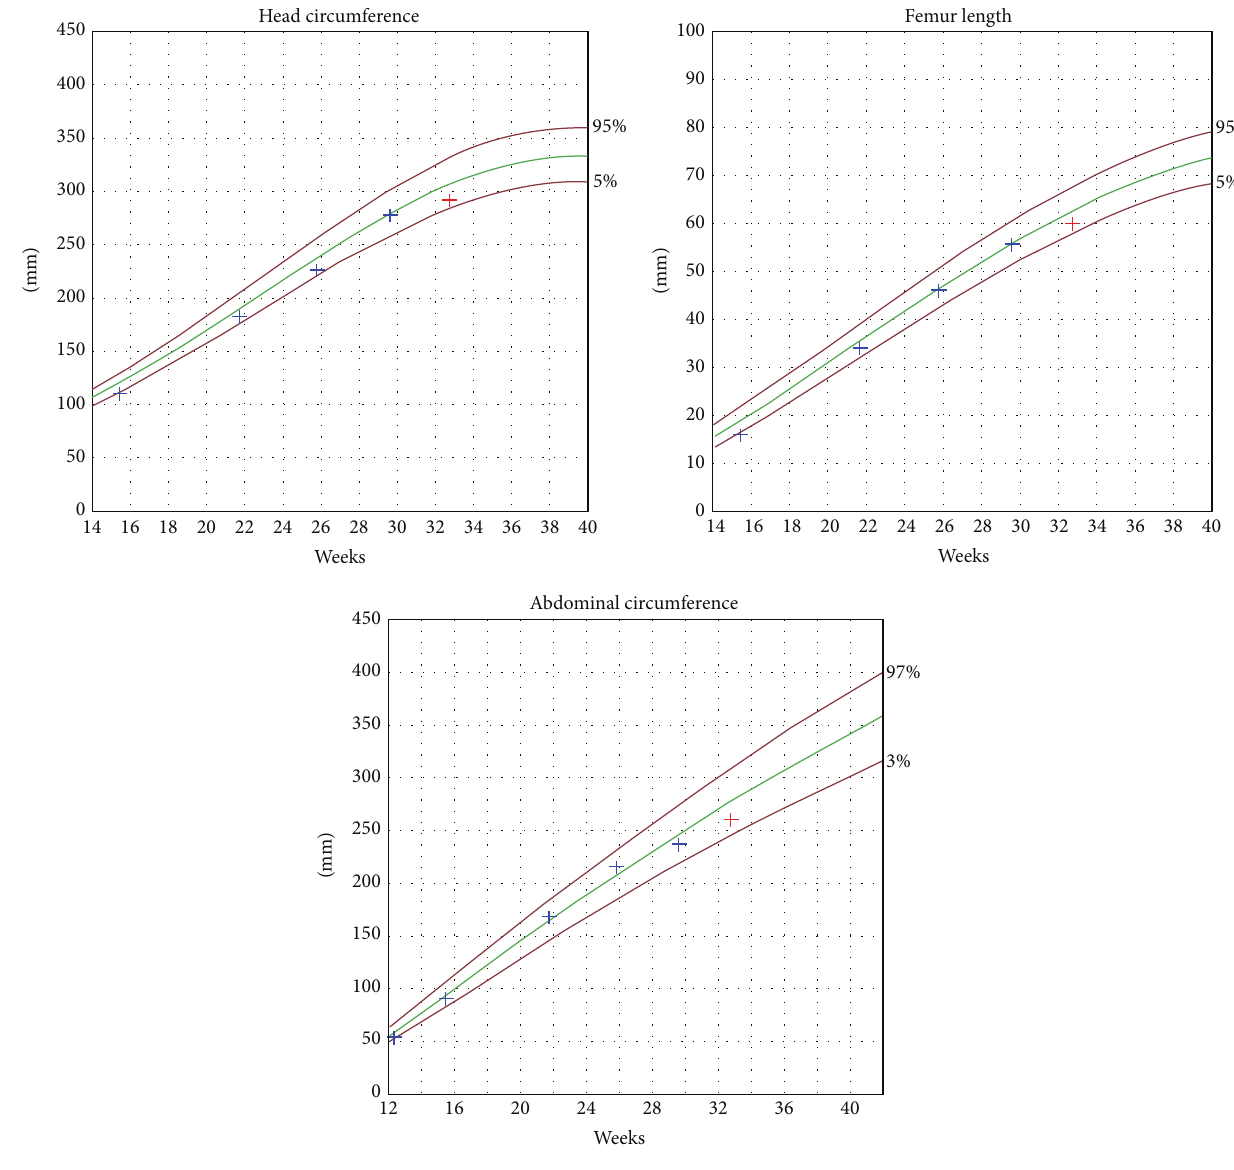
Figure 1: Fetal growth percentiles of